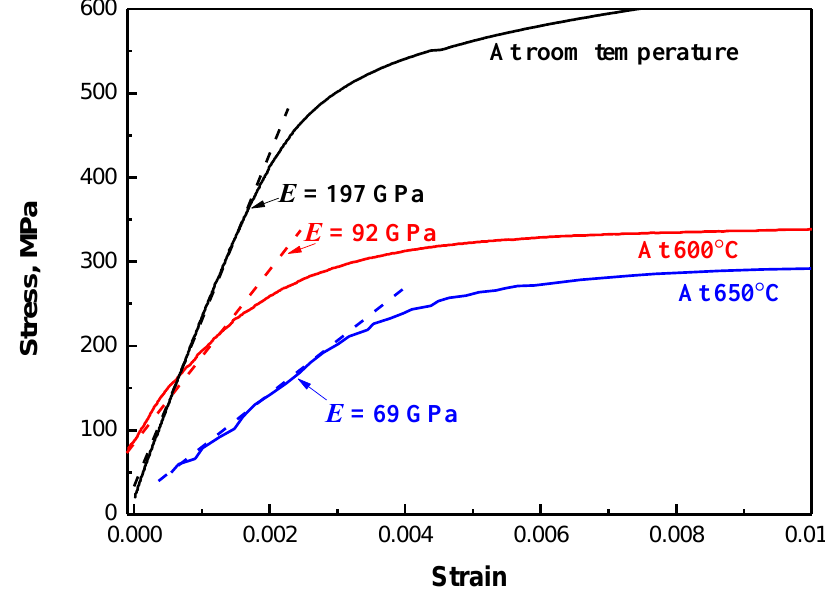
Figure 8. Fitted Young’s modulus E at room temperature and elevated temperatures of 600 °C and 650 °C from stress-strain